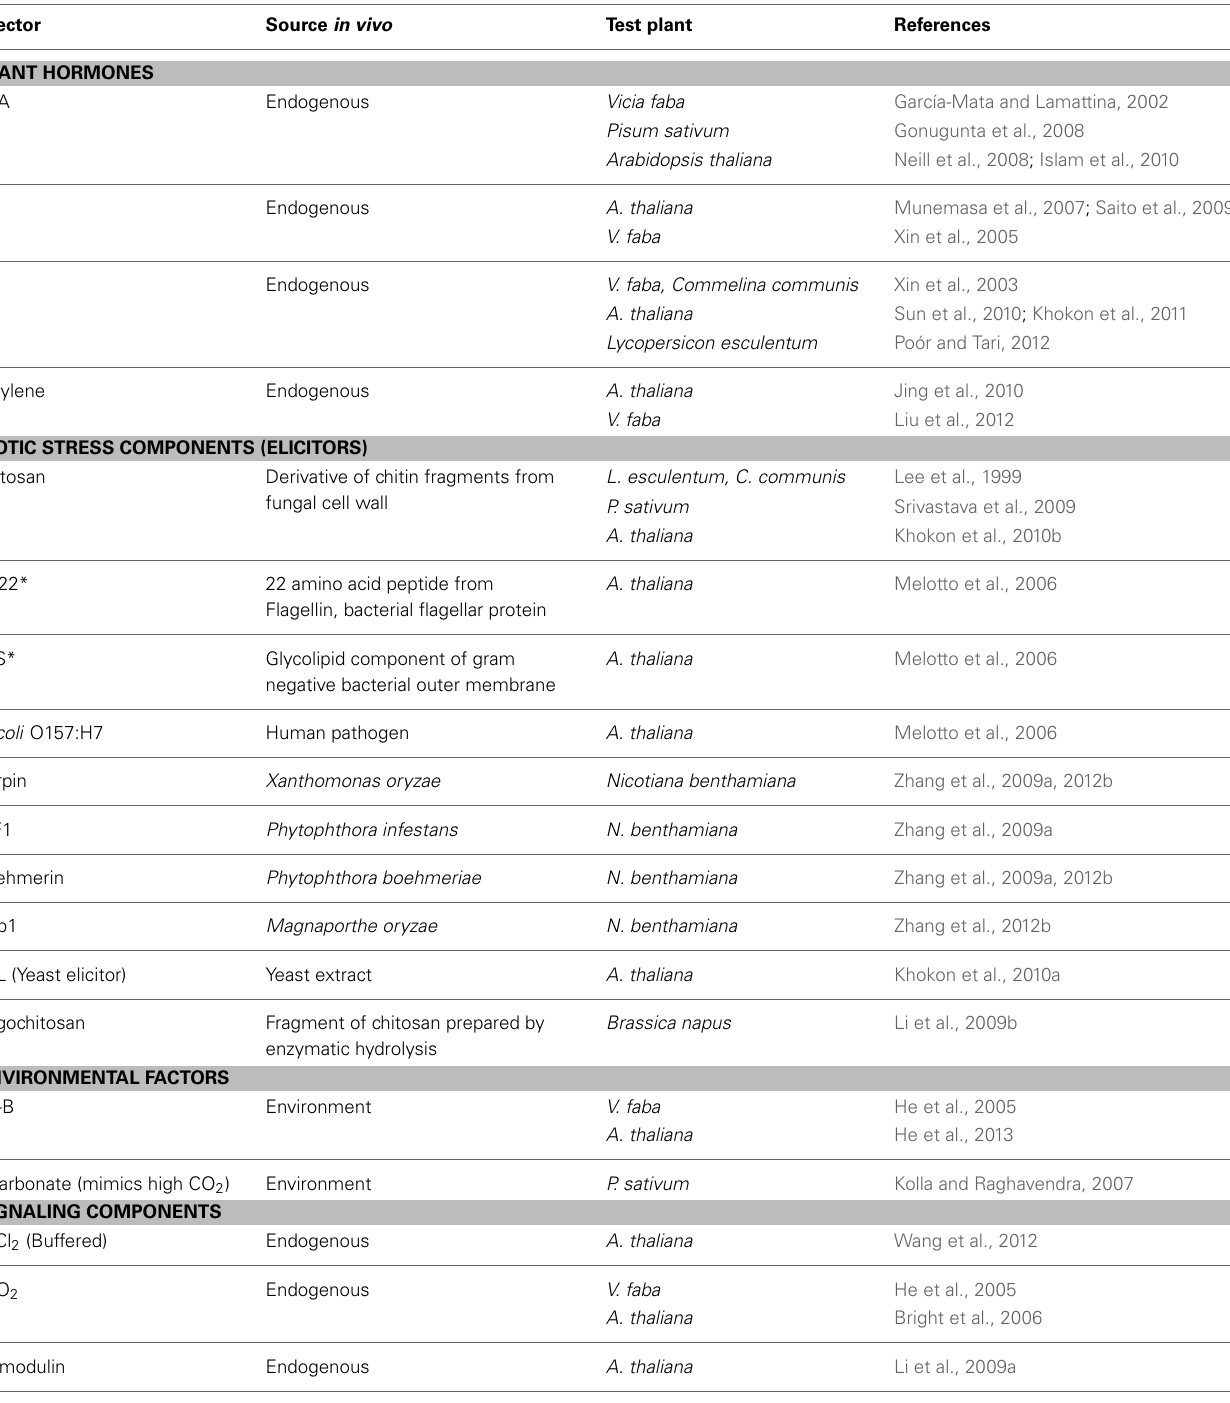
Table 1 | The rise in NO of guard cells as a common event during stomatal closure induced by hormones, elicitors or environmental factors.